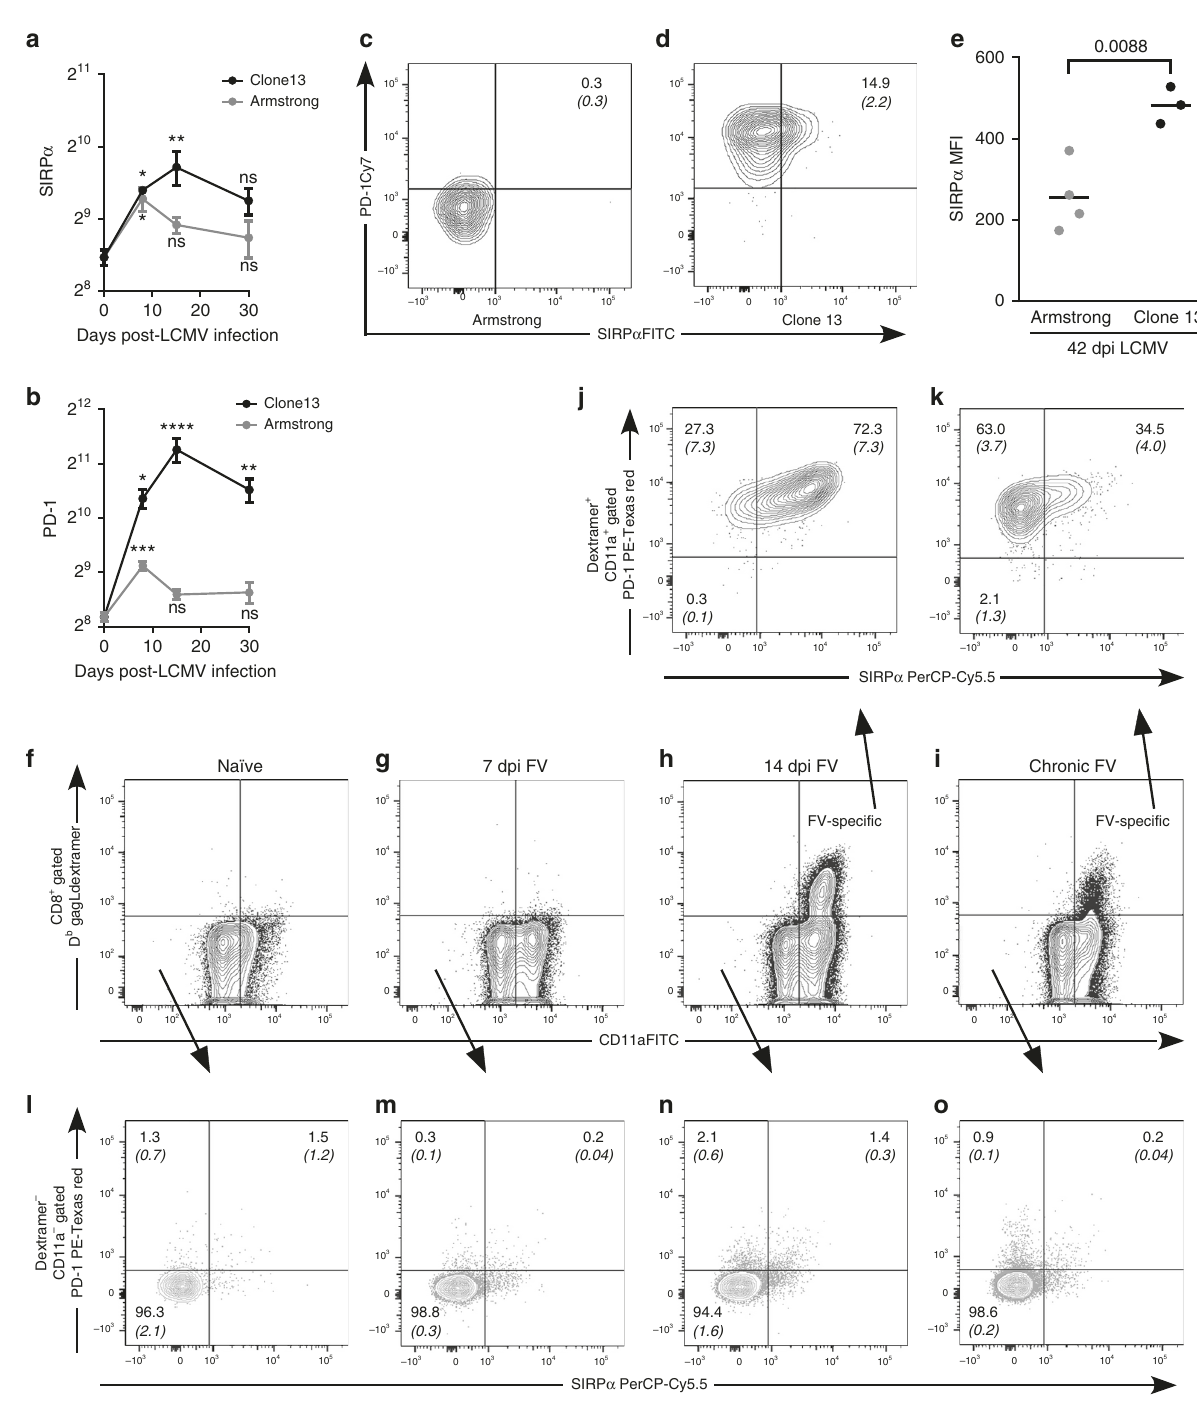
Fig. 1 Programmed cell death protein 1 (PD-1) and signal-regulatory protein alpha (SIRP α ) expression on CD8 + T cells during acute and chronic infection. Wild-type C57/BL6 mice were adoptively transferred with 1000 T cell receptor transgenic lymphocytic choriomeningitis virus (LCMV)-speci fi c CD8 + T cells from the spleens of naive P14 mice and then infected with either LCMV Arm or Cl13. The cells were then analyzed at multiple time points by microarray and the data were made publicly available 19 . SIRP α ( a ) and PD-1 ( b ) expression were analyzed by Dunnett ’ s multiple comparisons test with each time point compared to time zero ( n = 4 mice per time point except for d6 LCMV Arm, n = 3. SEMs are shown as bars). Representative fl ow cytometric contour plots of Thy1.1-gated, adoptively transferred P14 CD8 + T cells at 42 days postinfection with Arm ( c ) or CL13 ( d ) are shown. Numbers in the upper right quadrant are mean percentages of SIRP α + cells ( n = 4 Arm, n = 3 Cl13), P = 0.0029 by unpaired, two-way t test. Average mean fl uorescence intensity of SIRP α expression ( P = 0.0088 by unpaired two-way t test) ( e ). CD8 + splenocytes from naive ( f ), 7 dpi ( g ), 14 dpi ( h ), or chronic ( i ) Friend virus (FV)-infected mice were analyzed by fl ow cytometry for CD11a expression and FV-D b gagL dextramer staining. A representative fl ow cytometry plot is shown. Dextramer + CD11a + ( j , k ) and dextramer − CD11a − subsets ( l – o ) were further analyzed for PD-1 and SIRP α expression during the course of FV infection. Arrows originate in the quadrant further analyzed and point to the analysis. The percentage in each quadrant depicts the means from eight mice at each time point, with standard deviations in parentheses. The fl ow cytometric gating strategy is shown in supplementary Fig. 6a – d. Not signi fi cant (ns), p > 0.05, *p ≤ 0.05, **p ≤ 0.01, ***p ≤ 0.001, ****p ≤ 0.0001 (unpaired, two-way t